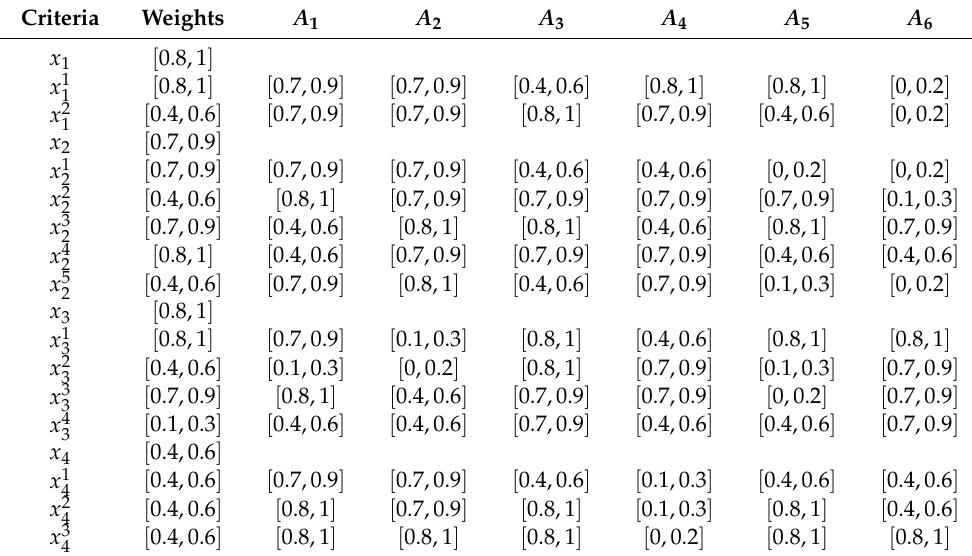
Table 4. The value of α -level cut set for α = 0 of Table 3. Criteria